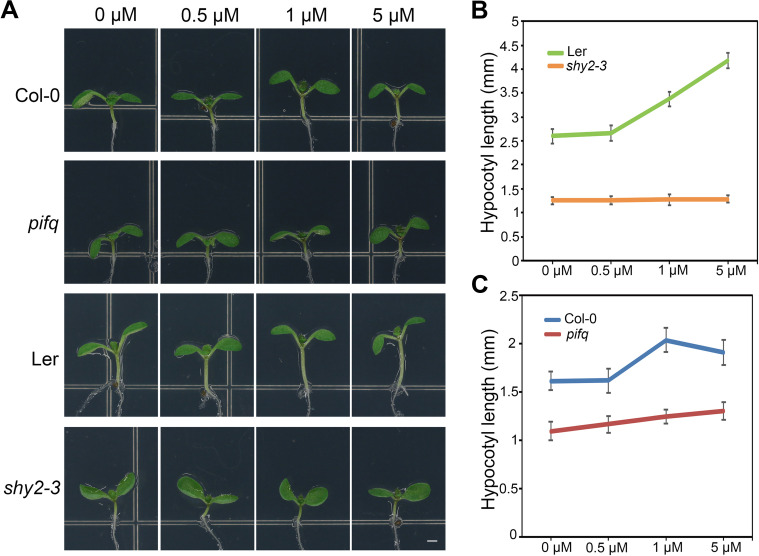
The auxin response in hypocotyl requires PIFs.(A) and (B) The analysis of auxin-regulated hypocotyl elongation indicated that PIFs are required for this growth response. Hypocotyl length of 5-day-old Col, pifq, Ler, and shy2-3 seedlings grown under long-day conditions and treated with IAA at the indicated concentrations.